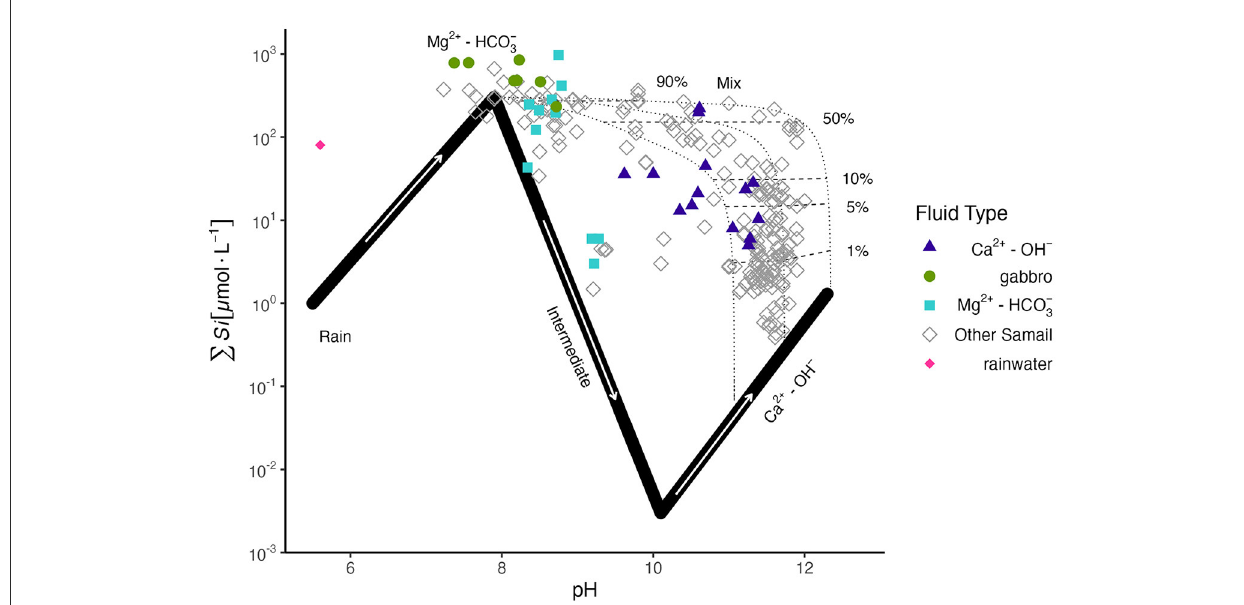
FIGURE1 Si vs. pH of sampled fluids in this study, colored by fluid type, and of other Samail Ophiolite data (Stanger, 1986; Dewandel et al., 2004; Chavagnac et al., 2013; Rempfert et al., 2017; Leong et al., 2021) in gray, with the reaction path model of Leong et al. (2021) for the progressive reaction of P rainwater with peridotite rock. Three potential Ca 2 + -OH − compositions of varying used as a conservative tracer to distinguish the extent of mixing between Ca 2 + -OH − and Mg 2 + -HCO − 3 fluids (shown in the plot as percentages next to mixing tie-lines). Mixing proportions are reported in Supplementary Table